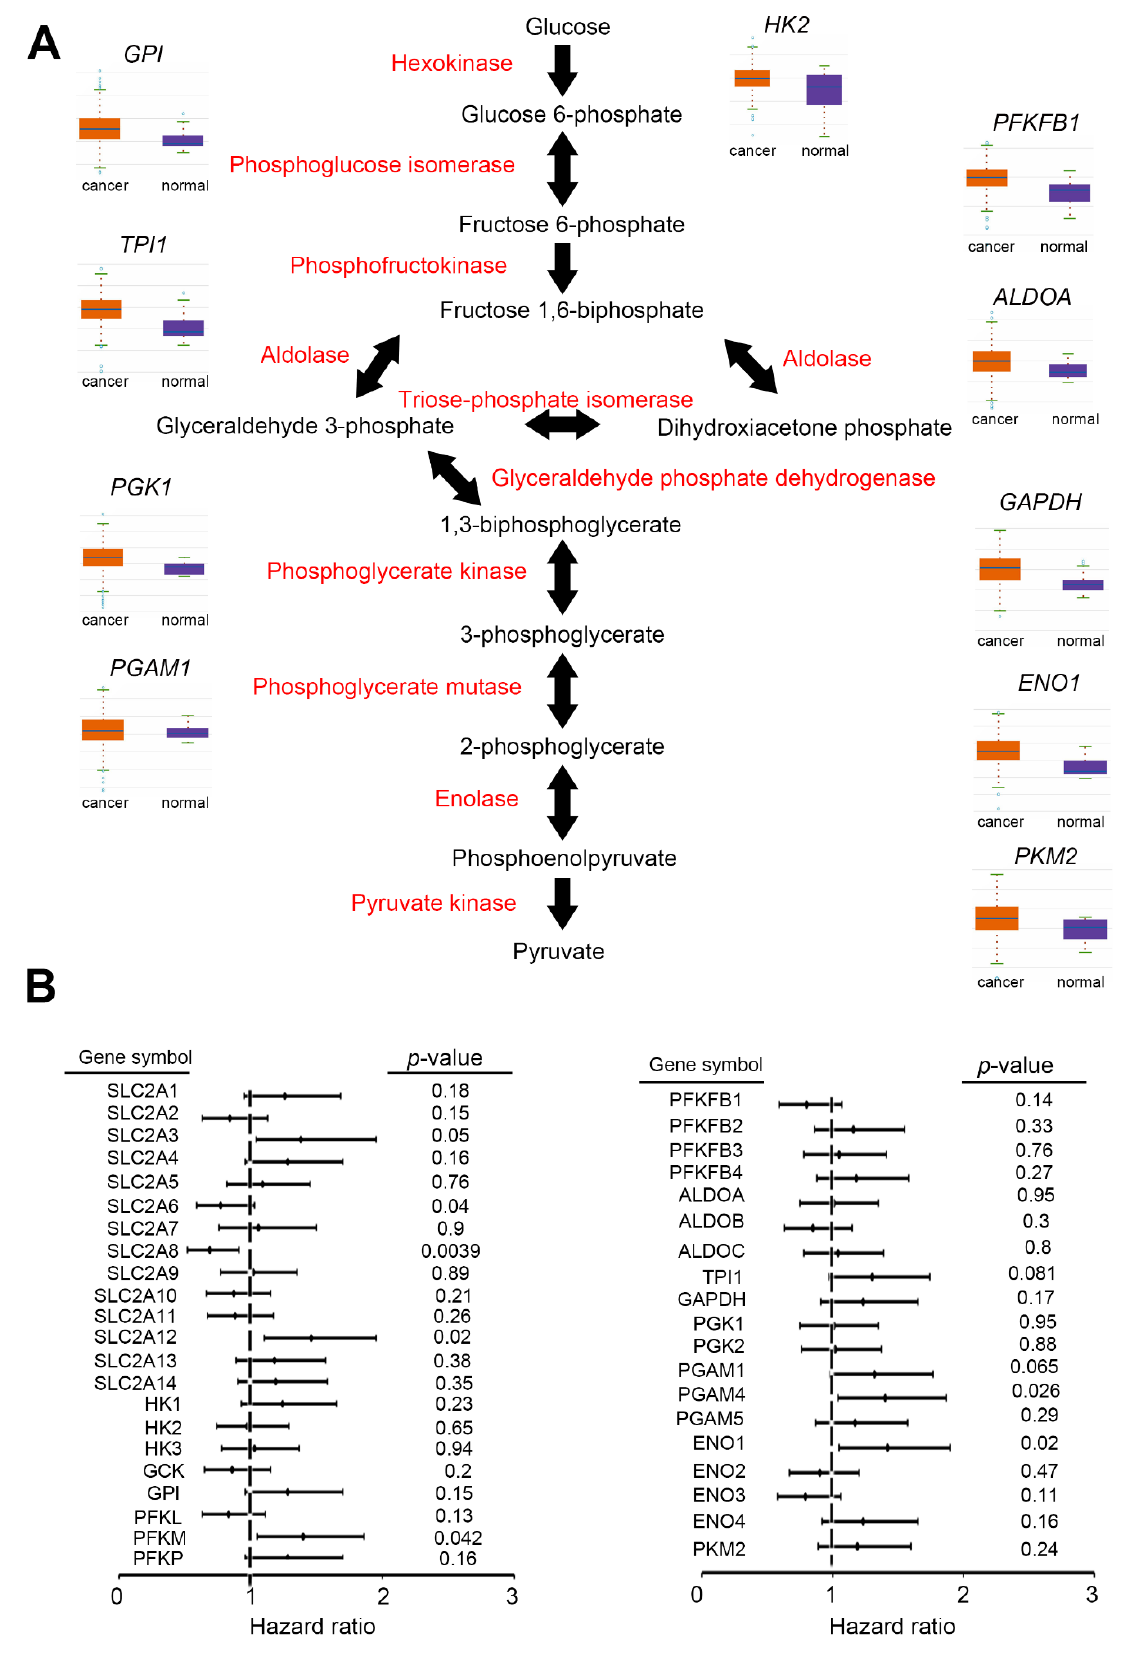
Figure 2. Glycolytic pathway was up-regulated in urothelial cancer. ( A ) Relative glycolytic enzymes mRNA levels in BC tissues. ( B ) Hazard ratio, p -value, and expression level of each glycolytic enzyme in urothelial cancer. All data were acquired from Kaplan – Meier Plotter, USCS Xena, and ENCORI websites.